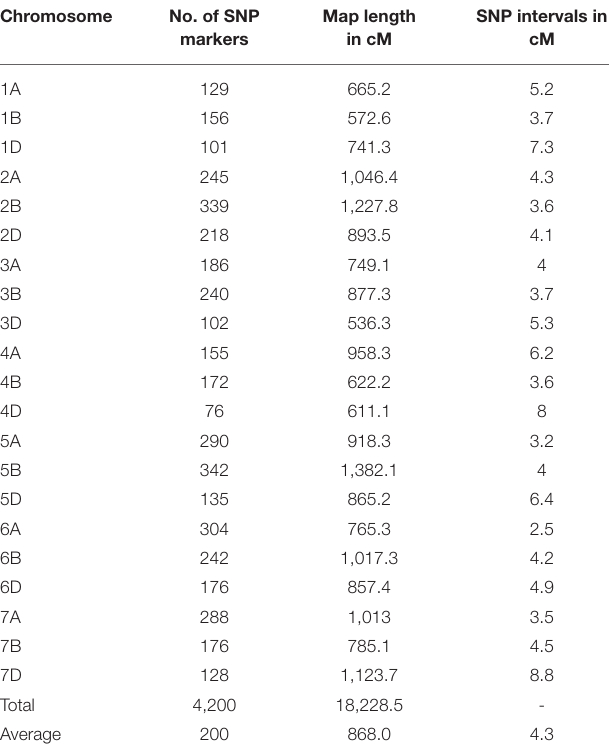
TABLE 3 | Summary of chromosome assignment, number of SNP marker, map length, and marker density of the SNP genetic map of the 119 RILs from the cross of Mingxian 169 × Pindong